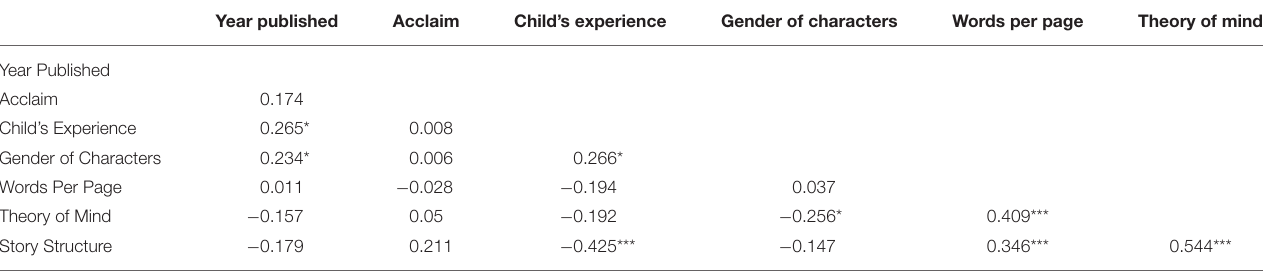
TABLE 2 | Pearson correlation analyses of the book content